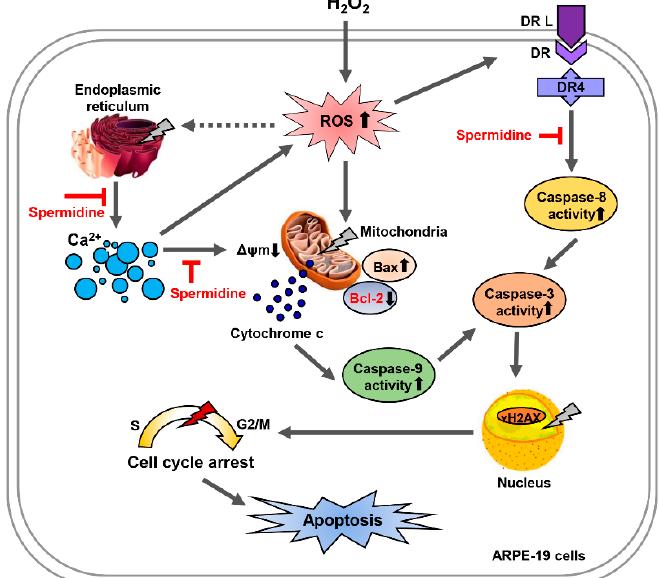
Figure 7. Spermidine attenuates H 2 O 2 -induced cellular dysfunction via suppression of Ca 2+ signal- ing pathways in ARPE-19 cells. Oxidative stress by H 2 O 2 triggers apoptosis through the intrinsic and extrinsic pathways in ARPE-19 cells. Spermidine markedly attenuated mitochondrial and nu-